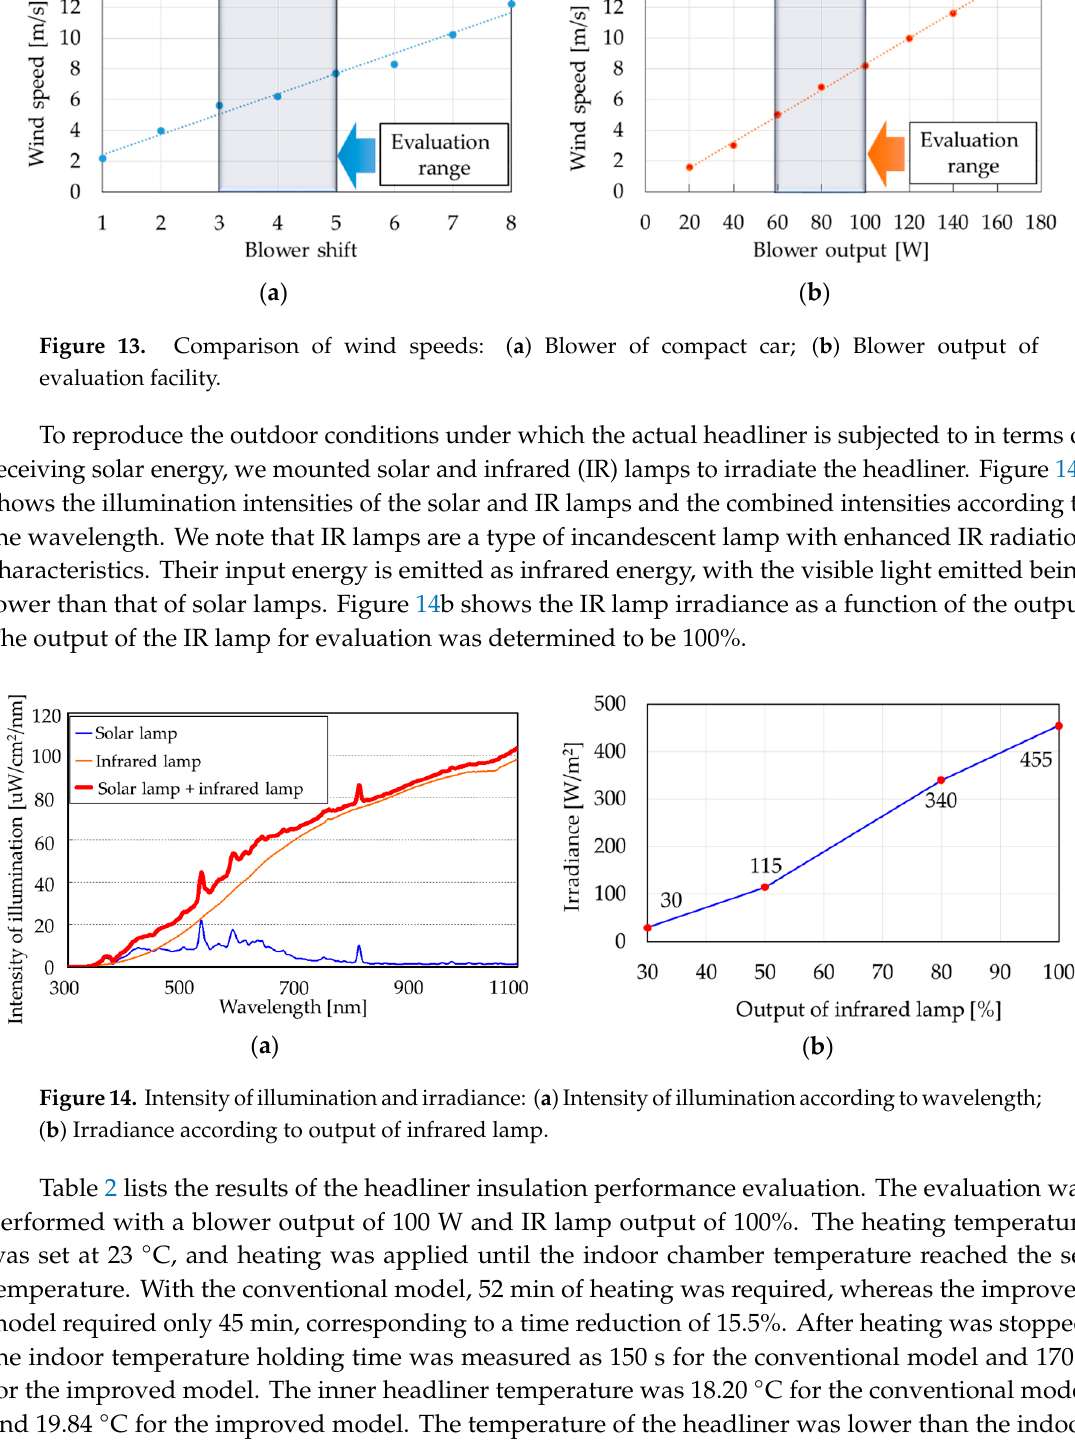
Table 2. Headliner insulation performance evaluation result.